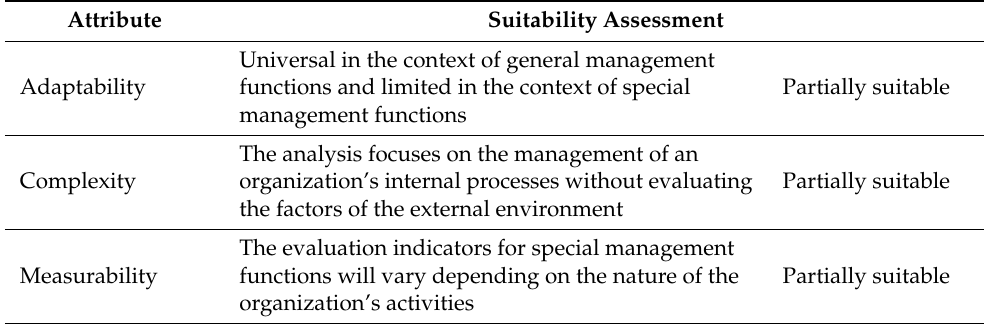
Table 9. Suitability assessment of the management functions approach based on the identified attributes.